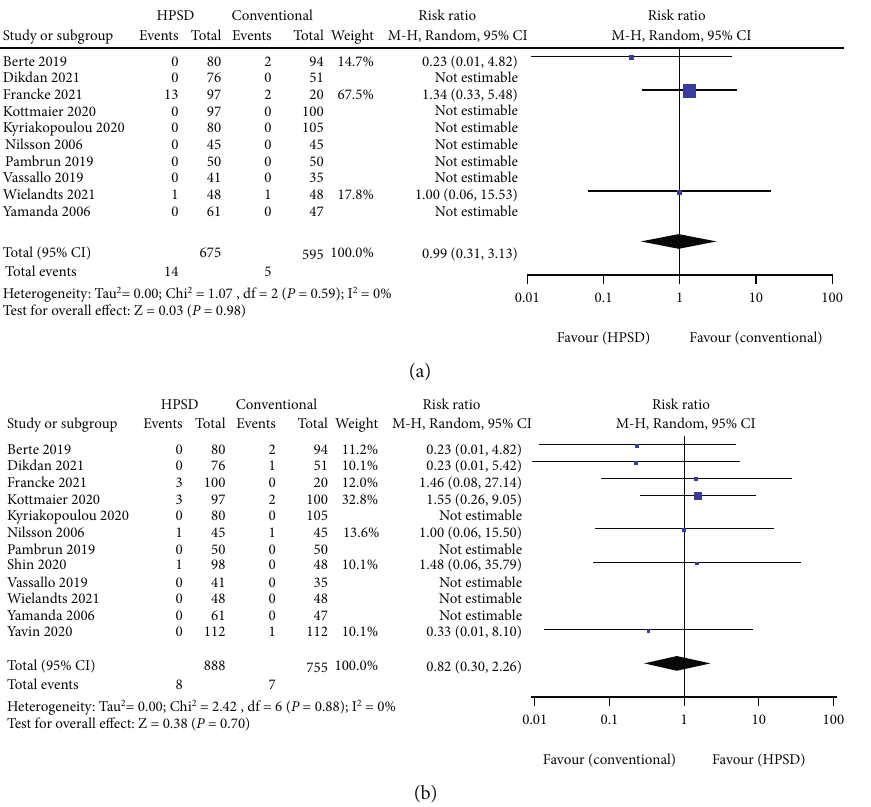
Figure 4: Forest plot of pooled e ff ect demonstrating (a) esophageal injury and (b) major complications in high-power short-duration (HPSD) and conventional ablation settings. 95% CI: 95% con fi dence